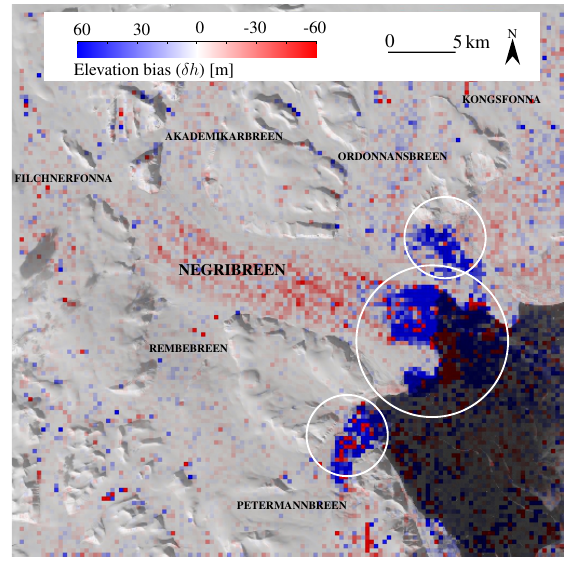
Figure 3. Estimated daily velocity of the Negribreen glacier system for April 2018.